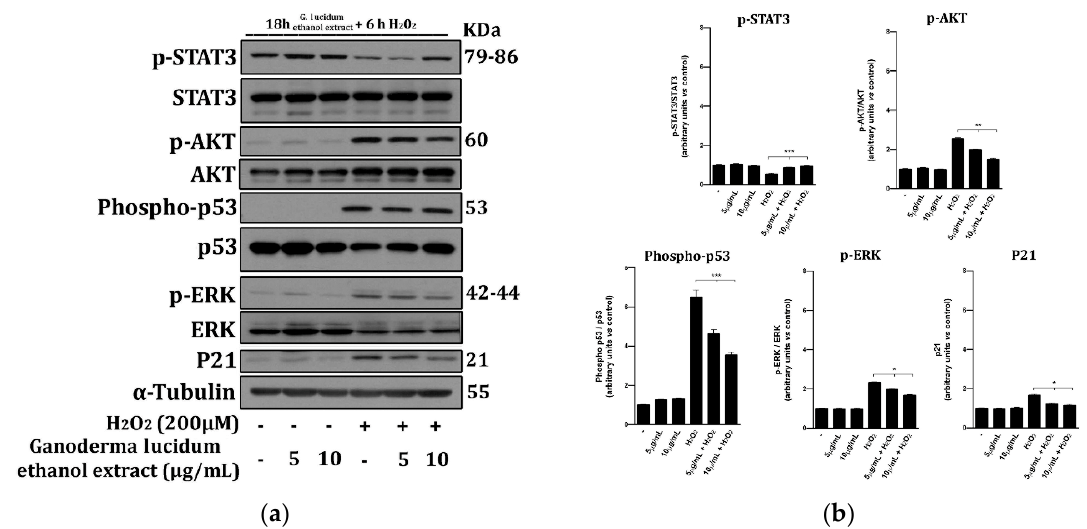
Figure 6. Ganonderic acid extract prevented the activation of cell death molecular pathways. ( a ) Western blot analysis of STAT3, AKT, p53, ERK (total and phosphorylated) and p21 in whole cell extracts from HaCaT cells cultured for 18 h in the presence of the indicated concentrations of the G. lucidum ethanol extract and H 2 O 2 for 6 h: Tubulin was used as a control for protein loading. The panel shows a representative Western blot of three di ff erent experiments performed with similar results. ( b ) Histograms represent mean ± SD in densitometry units of scanned immunoblots from the 3 di ff erent experiments (ANOVA, *** p < 0.001, ** p < 0.01 and * p < 0.05). The phosphorylation status of the abovementioned and p21 proteins in 18 h pretreated cells with